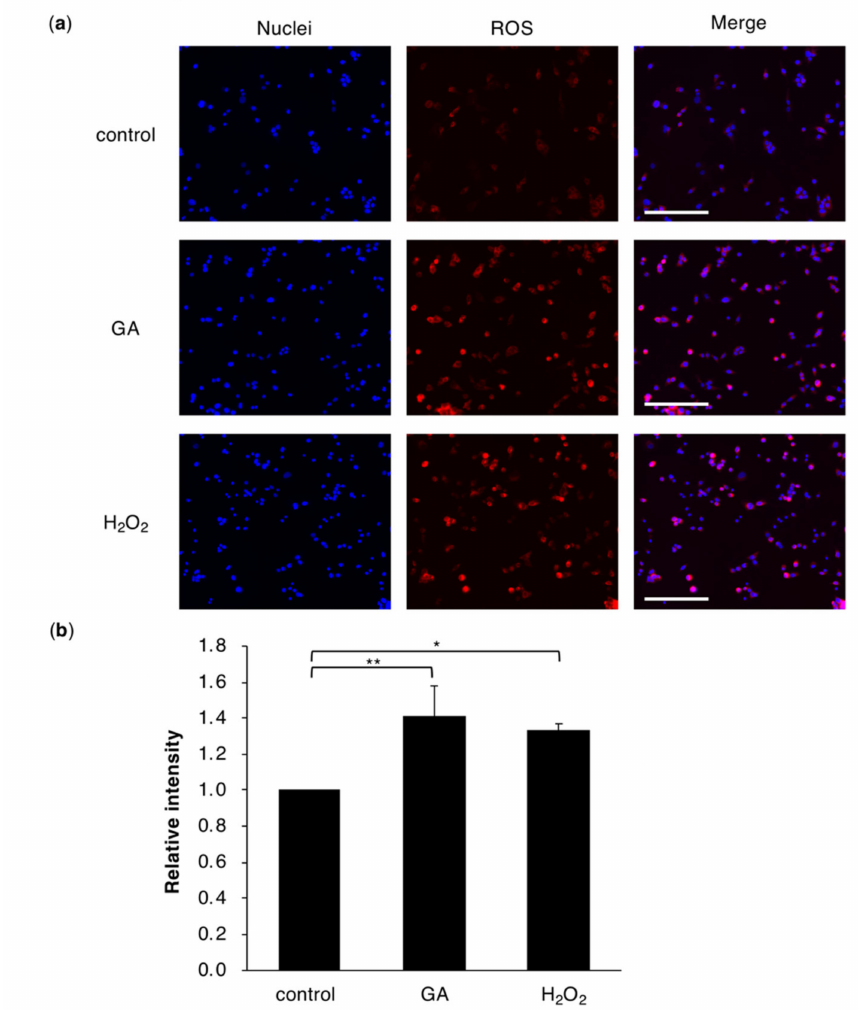
Figure 2. ROS accumulation in HepG2 cells treated with GA. ( a ) Representative fluorescence images of nuclei (Hoechst 33342; blue fluorescence) and ROS formation (OxiORANGE; red fluorescent) in HepG2 cells. Magnification for the figure is × 20. Cells were prepared from HepG2 cells treated with 0 or 4 mM GA or 1 mM H 2 O 2 for 6 h. Experiments were repeated in triplicate with similar results. Scale bar = 200 µ m. ( b ) The relative fluorescence intensity of HepG2 cells in each group. Results are mean ± S.D. * p < 0.05 and ** p < 0.01 ( n = 3) based on a one-way ANOVA followed by Dunnett’s